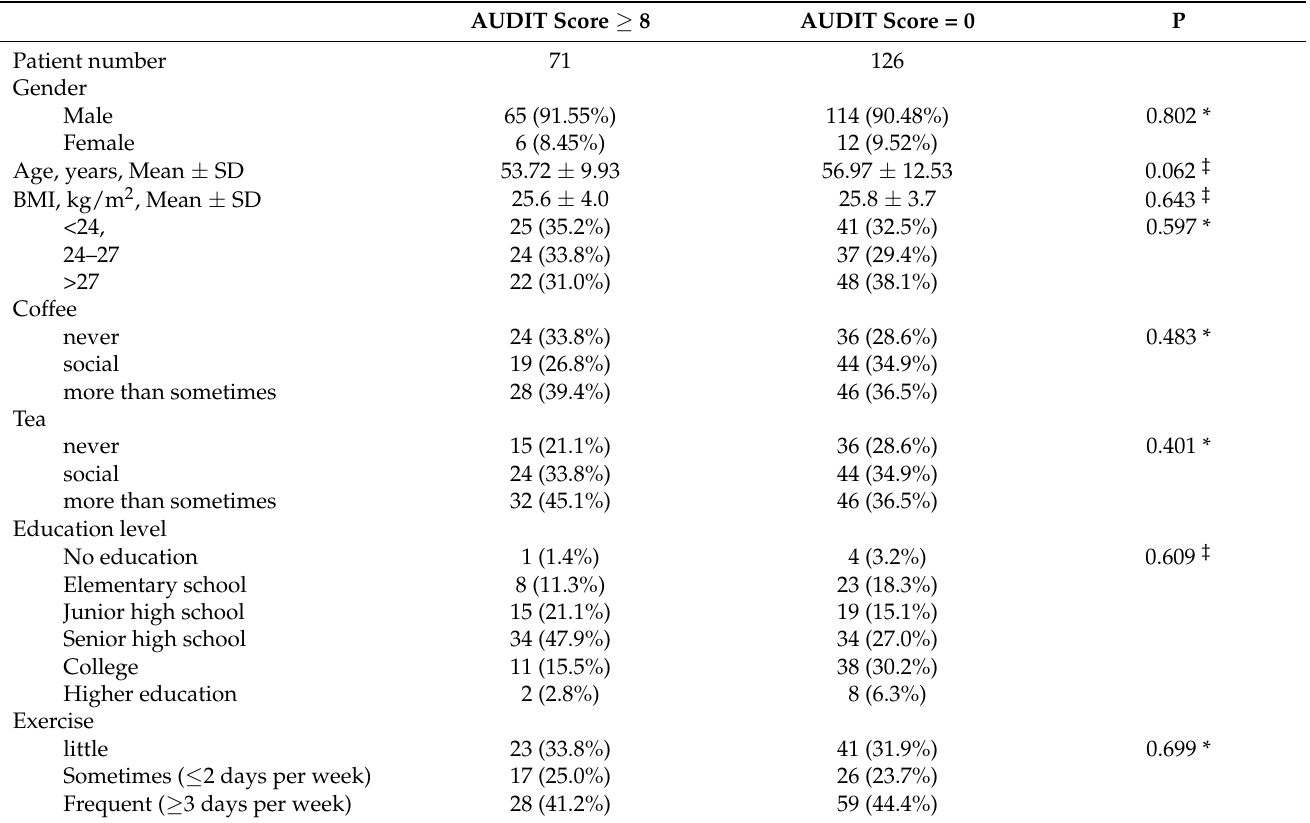
Table 1. Demographic information of subjects in this genome-wide association